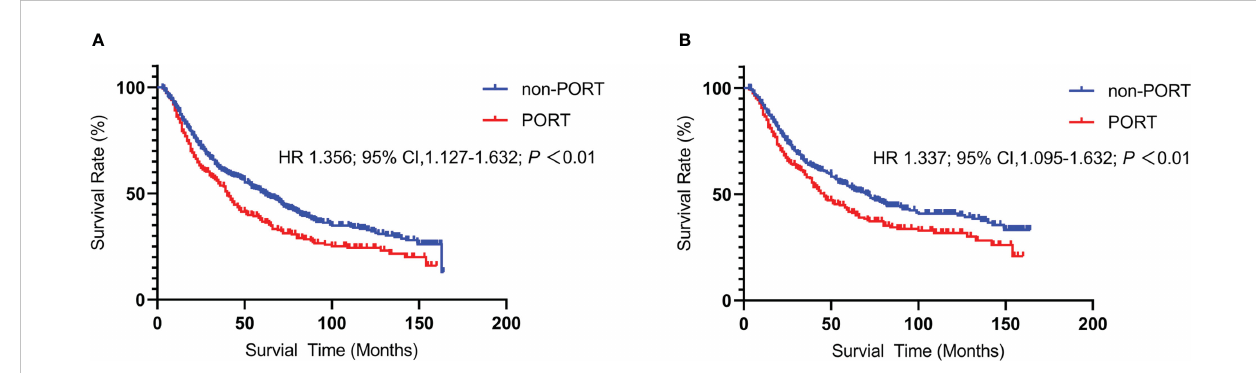
FIGURE 5 Kaplan-Meier curve of Overall Survival and lung-related death between the PORT group and the non-PORT group: Overall Survival (A) and lung- related death (B)